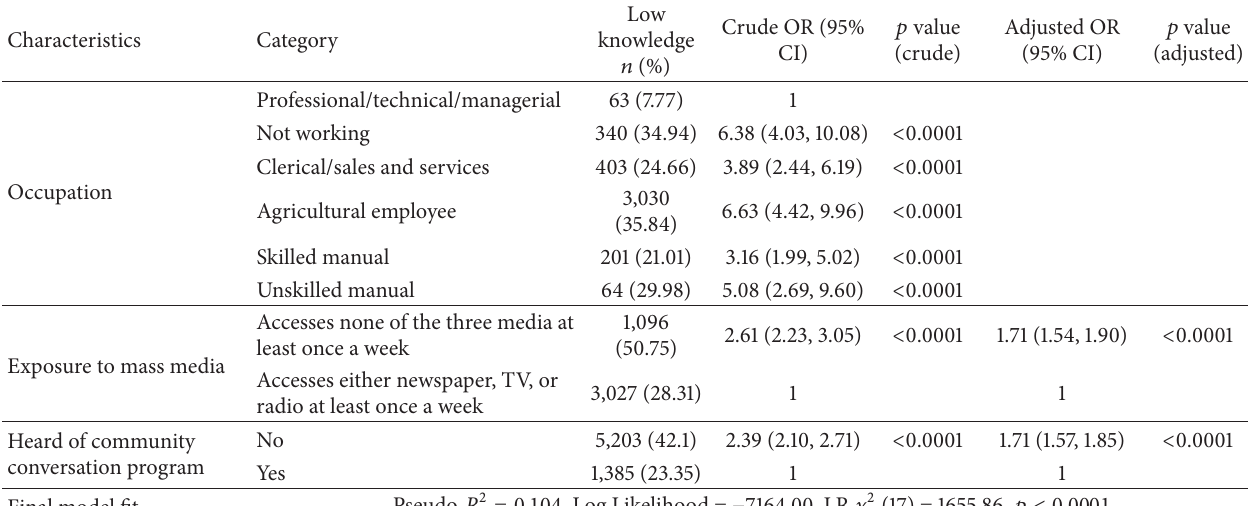
Table 7: Factors associated with low TB knowledge among Men, Ethiopia 2011,